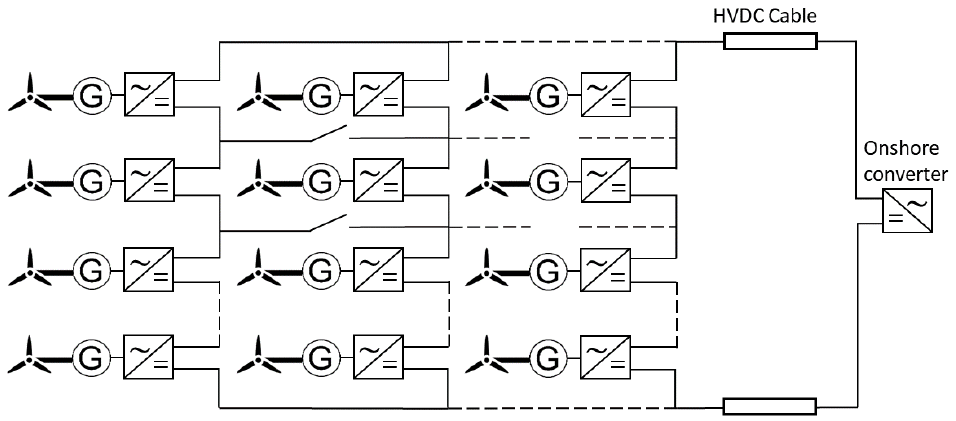
Figure 9. DC collection system with matrix-interconnected